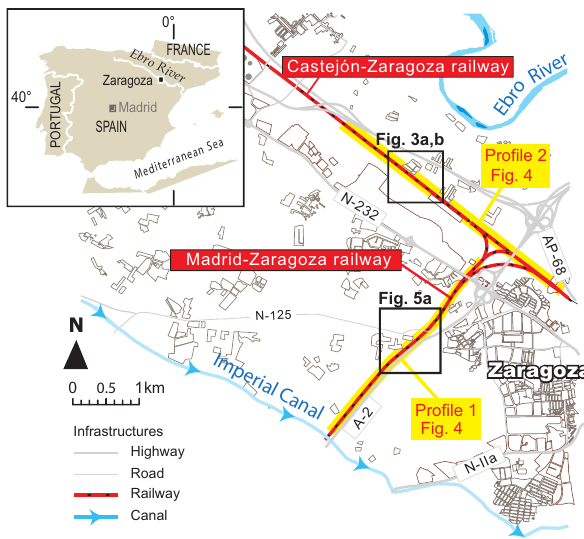
Figure 1. Geographic location of the studied railway sections.